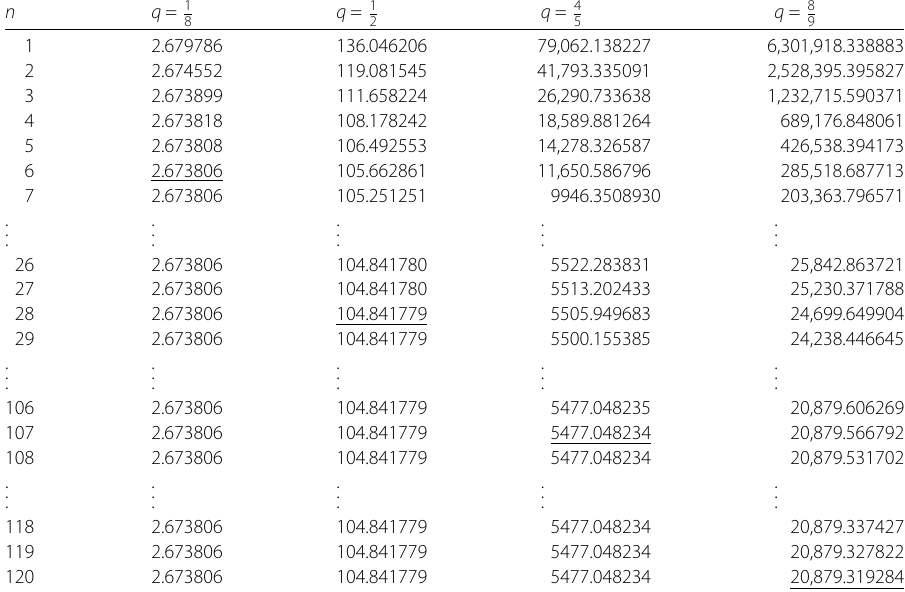
, 1 , 4 , 8 for x = 9.5 of Algorithm 8 2 5 9